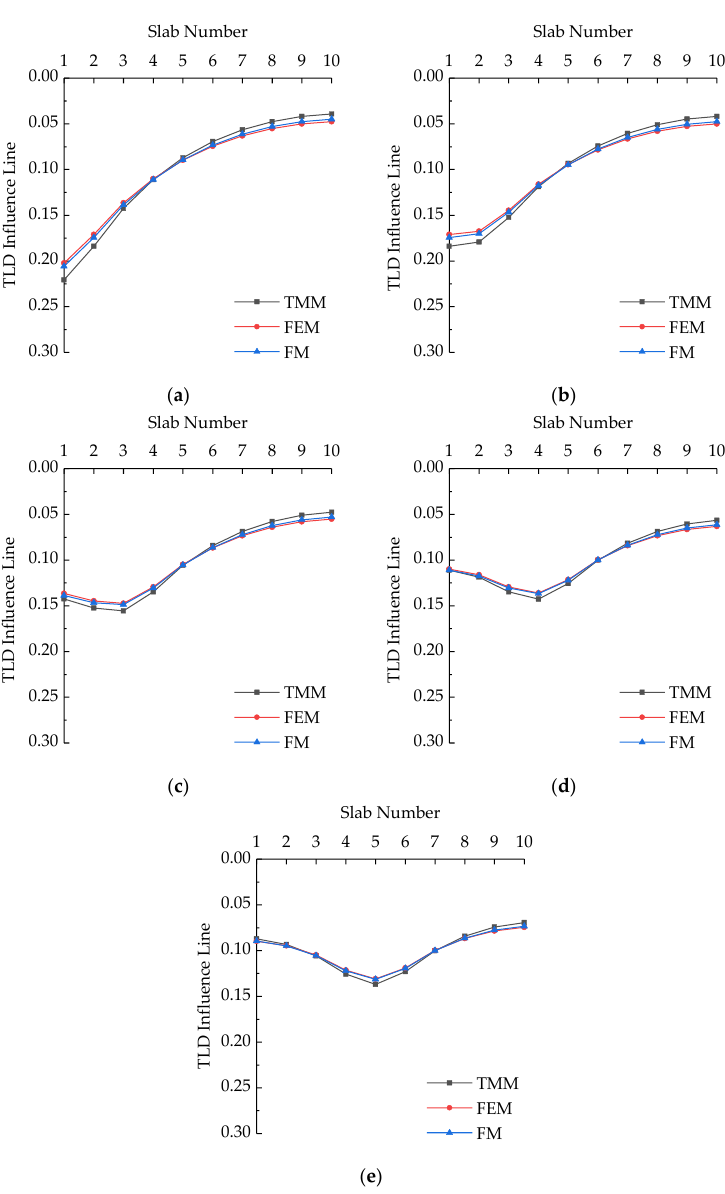
Figure 10. The TLD influence lines of each slab in the midspan: ( a ) slab 1; ( b ) slab 2; ( c ) slab 3; ( d ) slab 4; ( e ) slab 5.